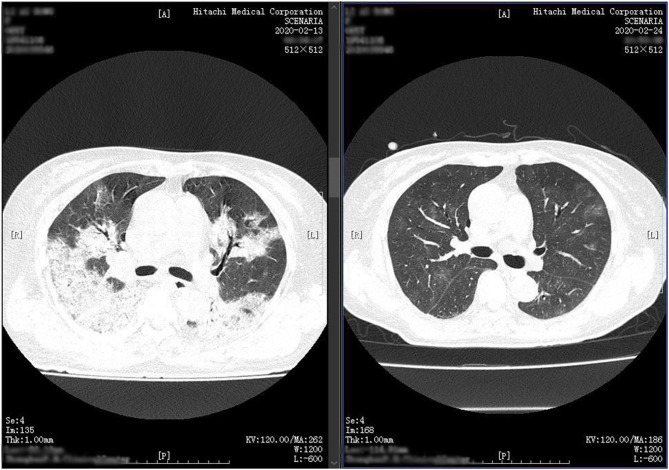
After glucocorticoid therapy, chest CT showed a significant decrease in the exudation of both lungs, suggesting decreased pulmonary inflammation.